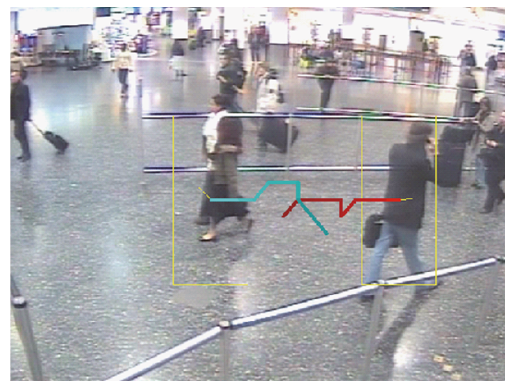
Figure 13: Retracking after occlusion.